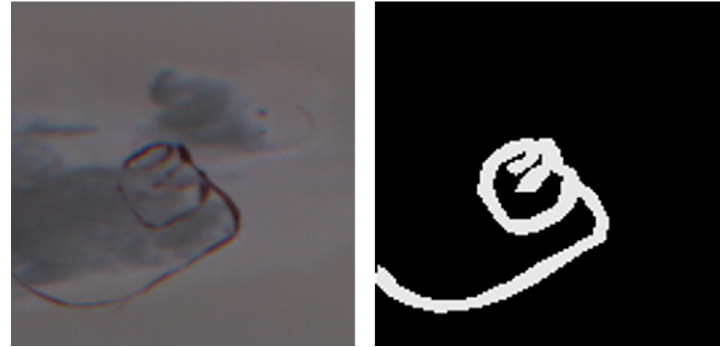
Figure 18. Cotton stalk (69%) misjudged as polypropylene (31%).